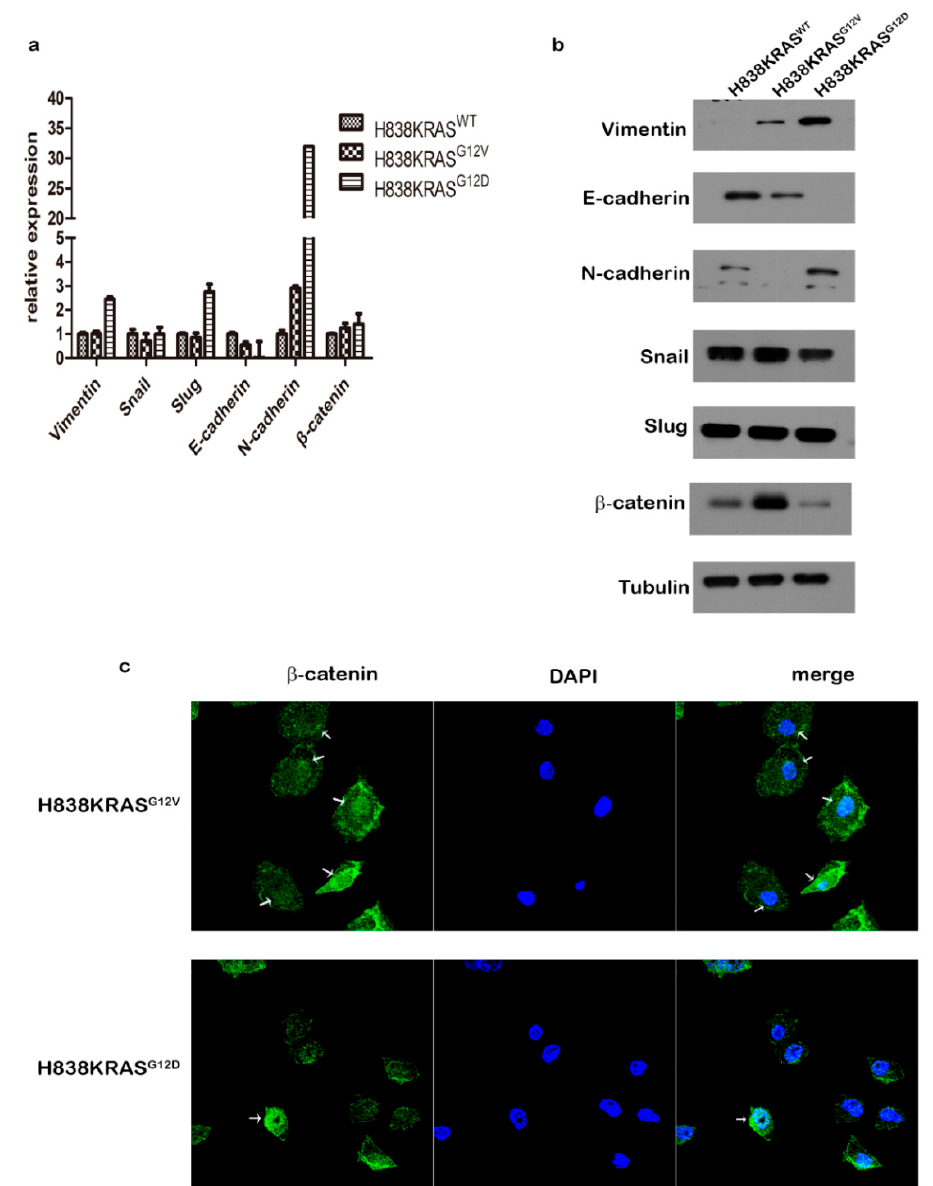
Figure 5. The expression profiles of epithelial-mesenchymal transition (EMT)-related genes in H838 KRAS isogenic cell lines. ( a ) The relative RNA expression levels of EMT-related genes were evaluated by real-time PCR. ( b ) Immunoblot analysis of EMT-related genes. Tubulin was used as an internal control. ( c ) The IF staining of β -Catenin in H838 KRAS isogenic cells. The β -Catenin is visualized with fluorescence staining. DAPI is nuclear stain. Immunoreactivity was demonstrated by confocal microscopy. The results of realtime PCR represent the means ± s.d. of three independent assays ( n = 3). The uncropped blots and molecular weight markers are shown in Figure S9.